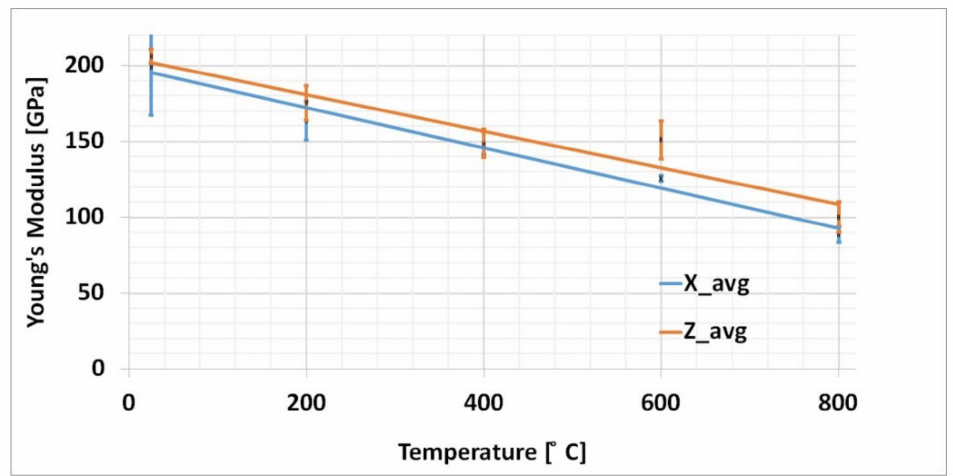
Figure 11. Average Young’s modulus at different temperature for samples oriented in the X - and Z